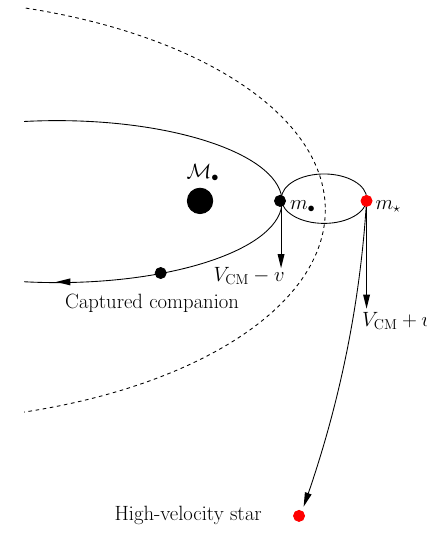
Fig. 51 Zoom of Fig. 50 for the splitting of the pair. I assume a parabolic encounter (dashed curve) for the COM of the binary and a mass m • and m (cid:4) for the